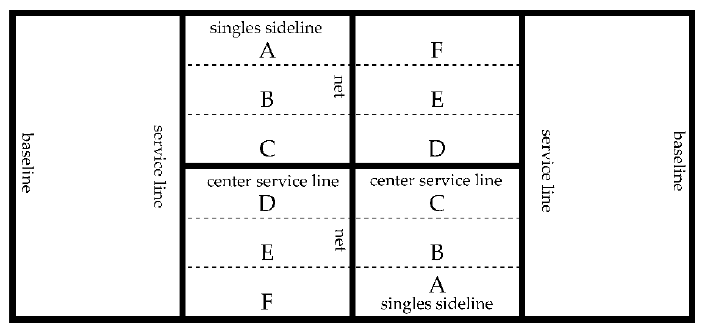
Figure 3. The returner’s impact location.